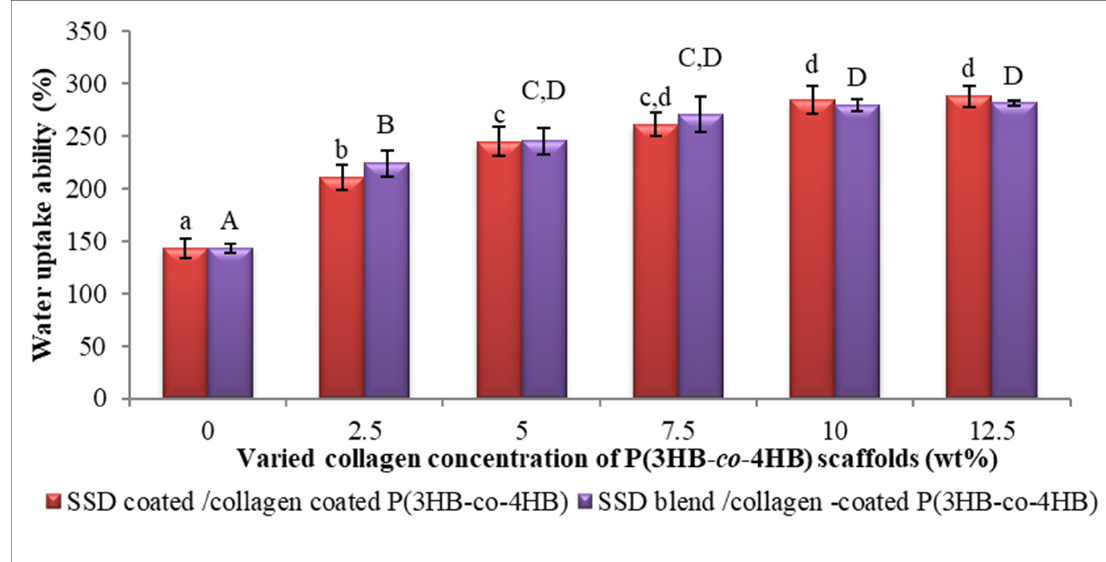
Figure 6. Water uptake analysis of SSD coated/collagen coated P(3HB- co -4HB); SCCC and SSD blend/collagen coated P(3HB- co -4HB); SBCC scaffolds. Data represent means ± SD ( n = 3). Mean data accompanied by different alphabets as of SCCC scaffolds (a–d) and SBCC scaffolds (A–D) indicates significant difference within each respective group (Tukey’s HSD test, p < 0.05).